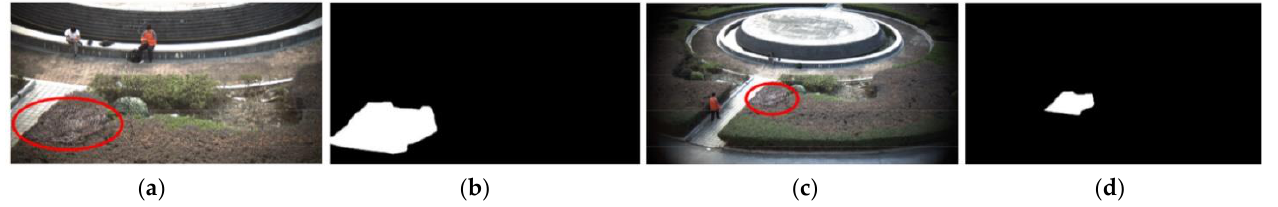
F obtained using 1